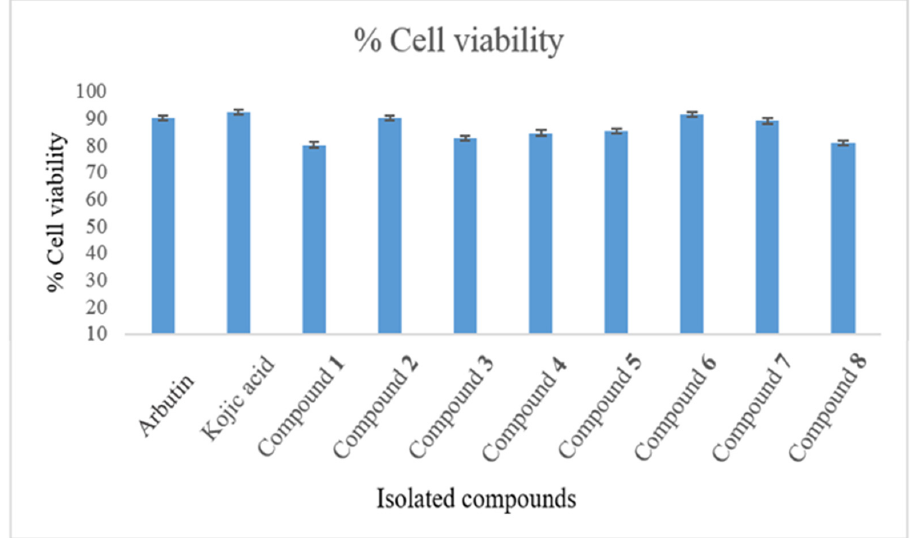
Figure 5. Cell viability of isolated compounds at a concentration 50 μ g/mL.